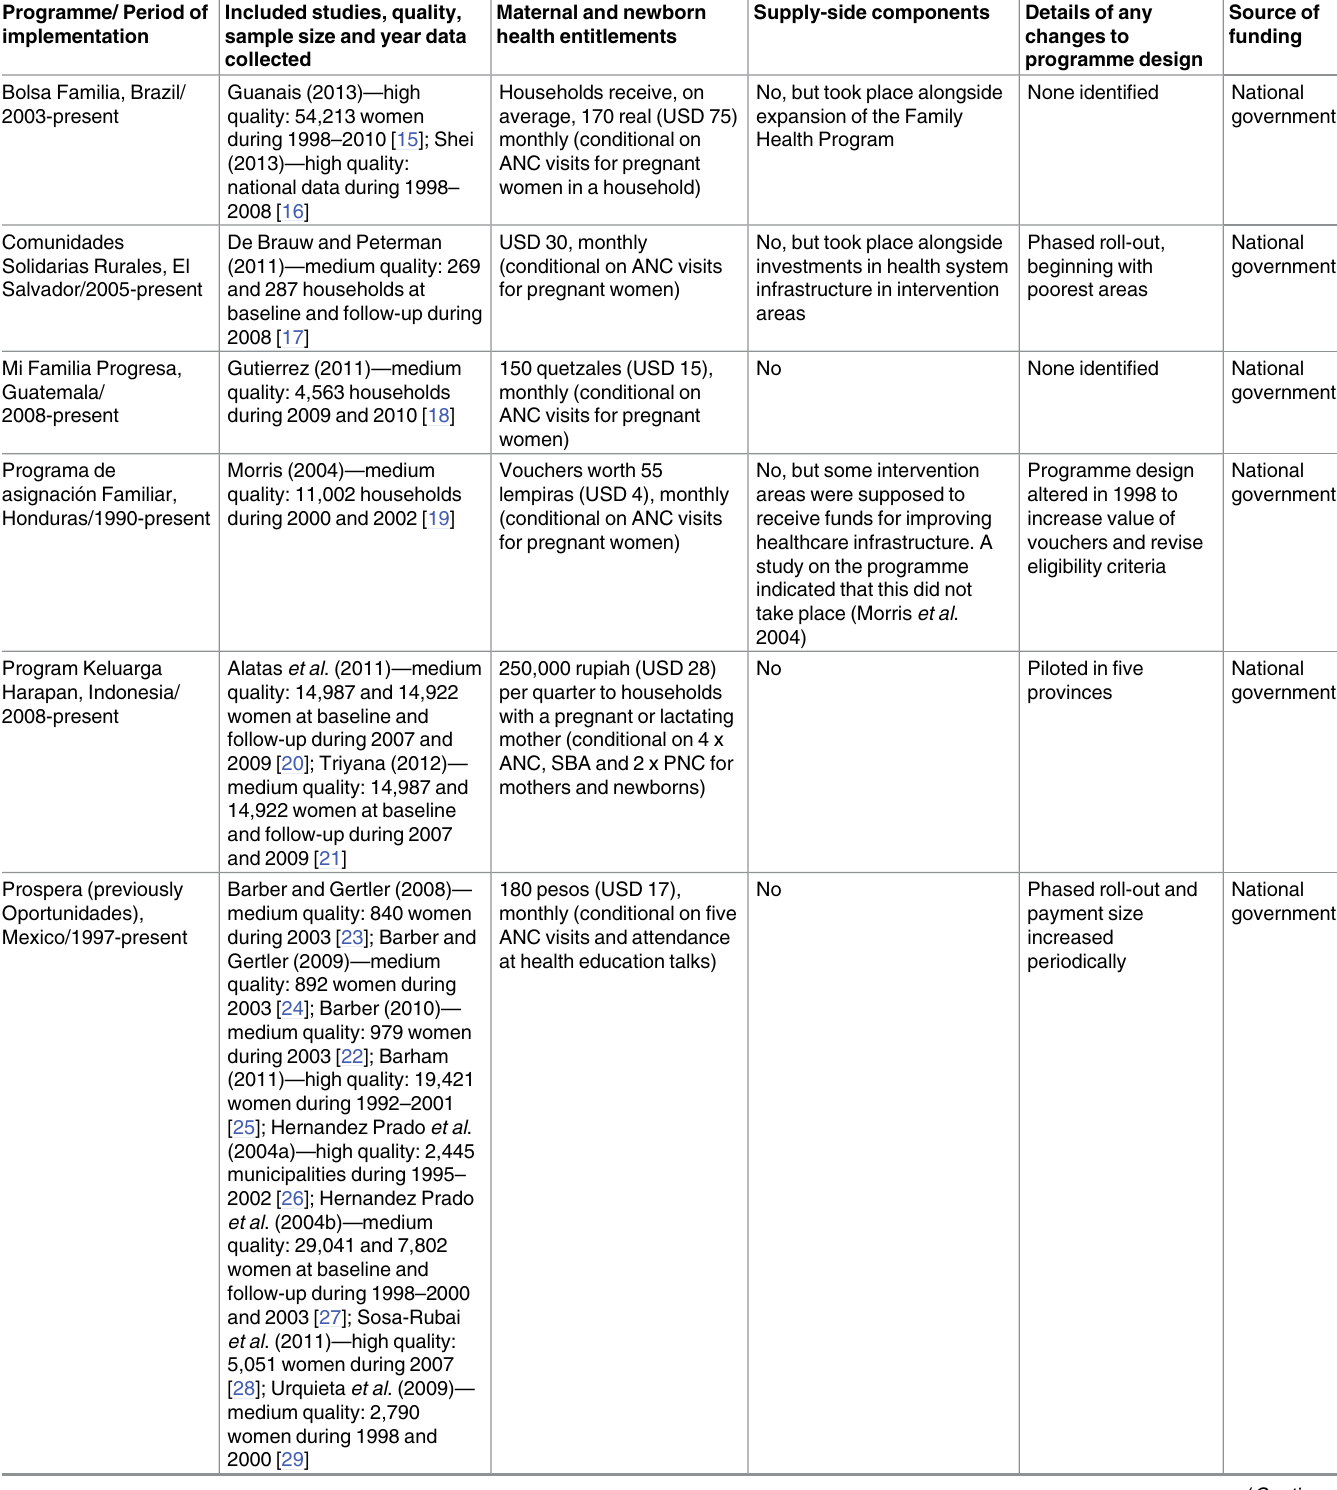
Table 2. Details of conditional cash transfer programmes included in the systematic